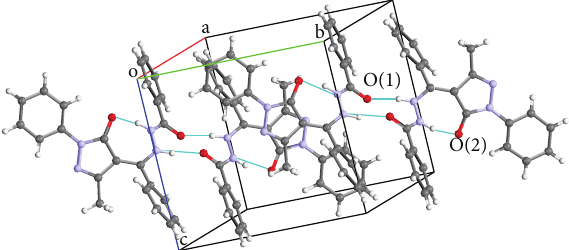
Figure 3: A view of the crystal packing of HL 1 showing the intramolecular and intermolecular hydrogen